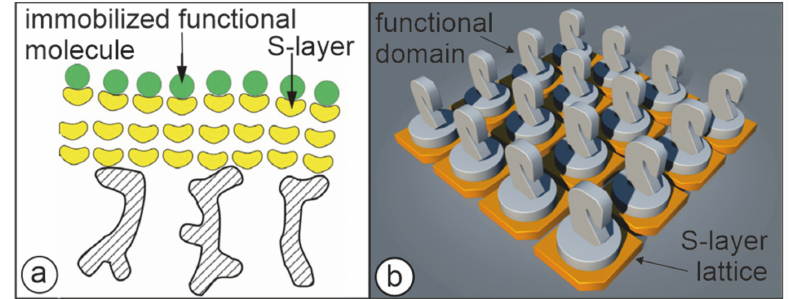
Figure 5. Cartoons illustrating the two major approaches to present functional molecules or domains on S-layer lattices. ( a ) S-layer ultrafiltration membrane comprising of S-layer proteins with covalently attached functional molecules. (Adapted from [72]. Copyright © 2011 with permission from Springer- Verlag). ( b ) Self-assembled S-layer fusion proteins carrying functional domains (represented as knights) in precise position and orientation. (With permission from Ref. [6] (CC BY-NC-ND